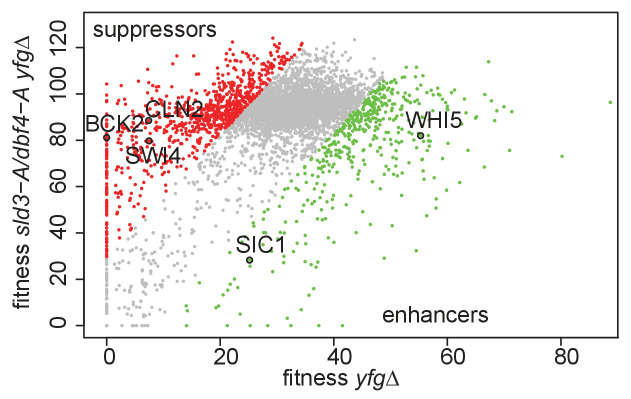
Genetic interactions of the sld3-A dbf4-A alleles with mutants that either accelerate or delay the G1/S transition.Scatter plot of the fitness of the yeast genome knock out collection grown in 0.5 μg/ml phleomycin with (y-axis) or without (x-axis) the sld3-A dbf4-A alleles. Each dot corresponds to a different gene deletion. The top 25% of gene deletions (yfg, your favourite gene) that significantly enhance (green) or suppress (red) the fitness of sld3-A dbf4-A are indicated. This data was originally published in Morafraile et al., 2019.